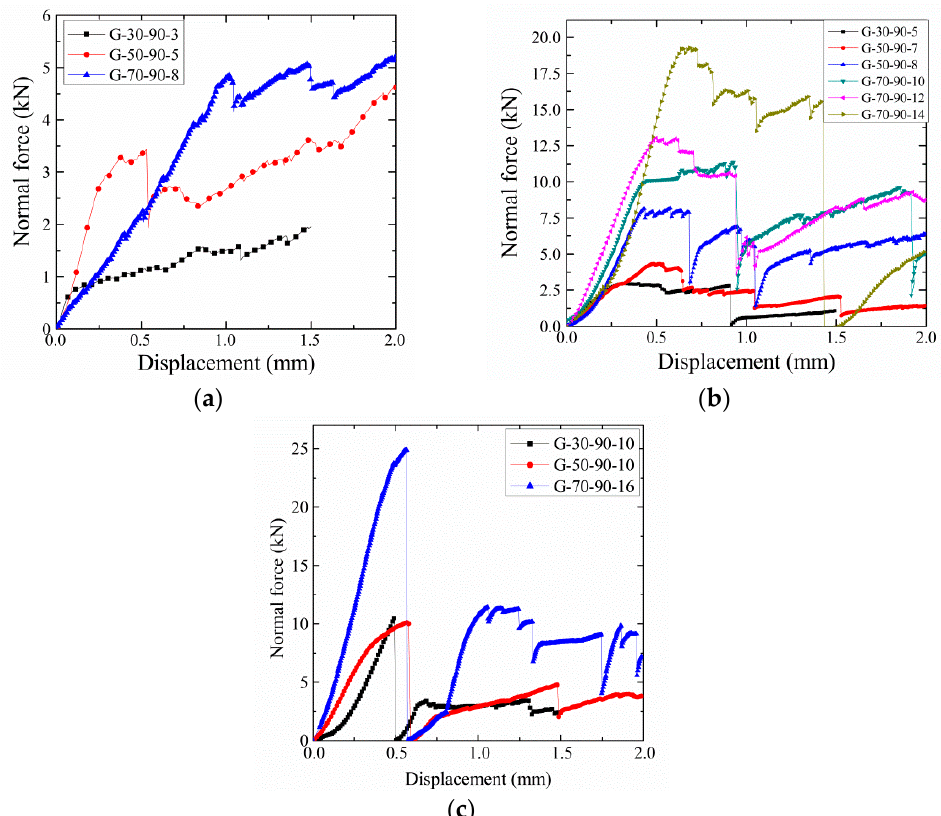
Figure 11. The typical force–displacement curves corresponding to three particle breakage modes: ( a ) peeling; ( b ) peeling–splitting; ( c ) splitting.